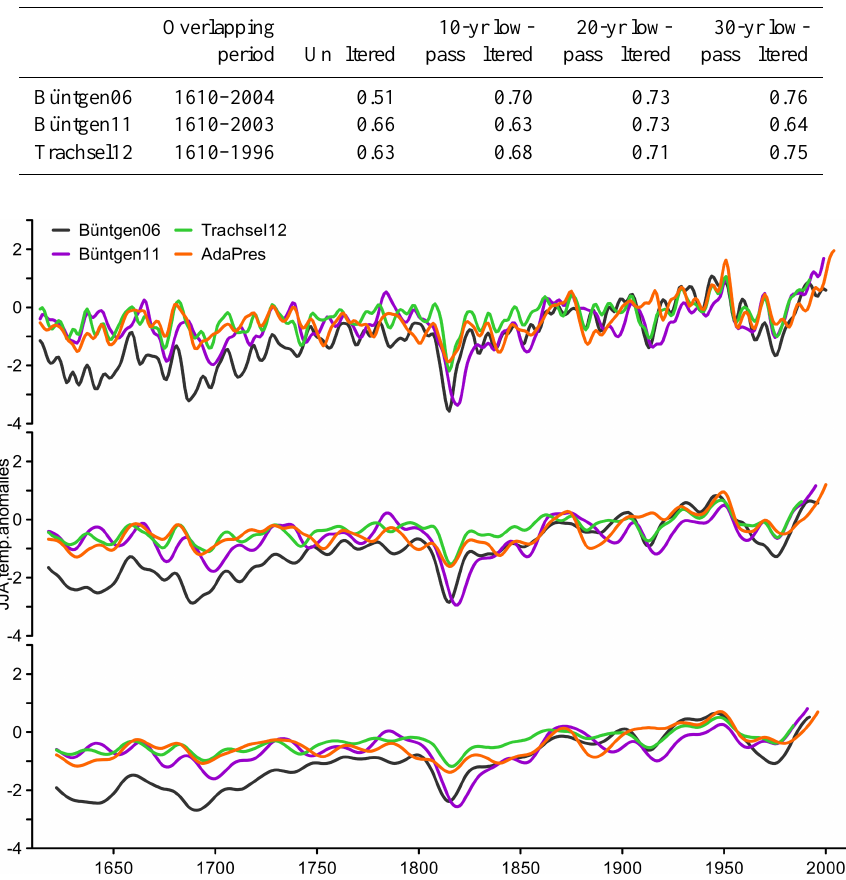
Fig. 7. Comparison between the AdaPres reconstruction and the three compared series (B¨untgen et al., 2006 (B¨untgen06), B¨untgen et al., 2011 (B¨untgen11), Trachsel et al., 2012 (Trachsel12)). All the series were smoothed by means of a Gaussian low-pass filter of 10 (top), 20 (middle) and 30yr